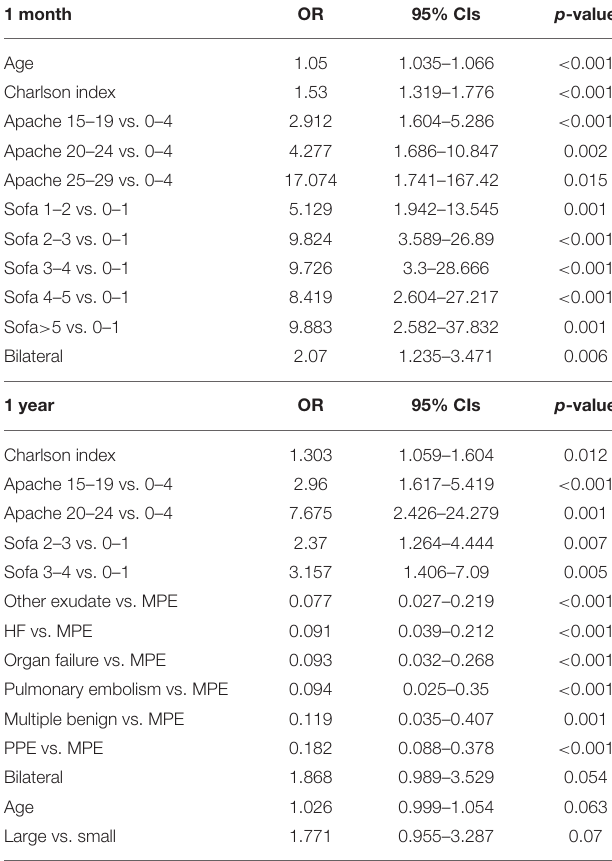
TABLE 5 | Multivariate predictors of mortality.